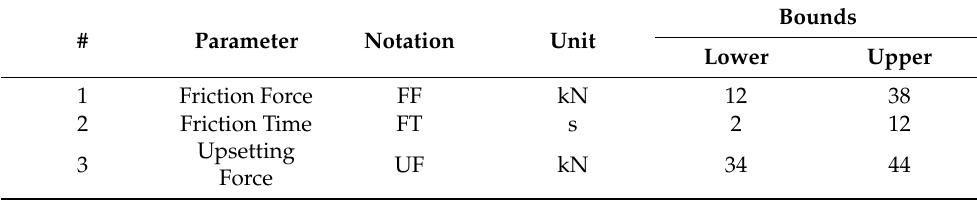
Table 3. Ranges of process